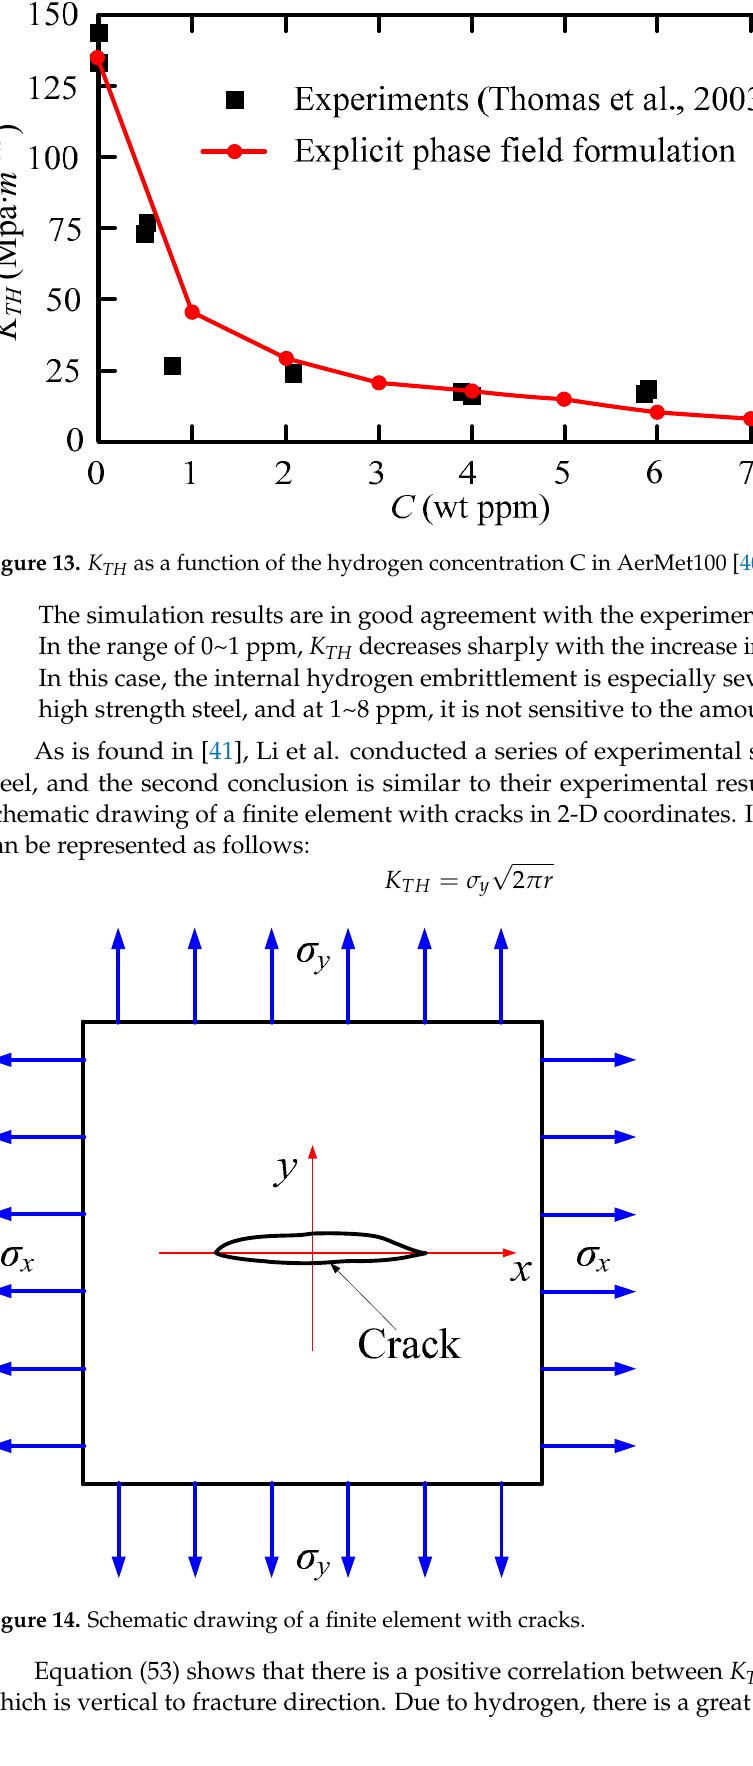
Figure 14. Schematic drawing of a finite element with cracks.